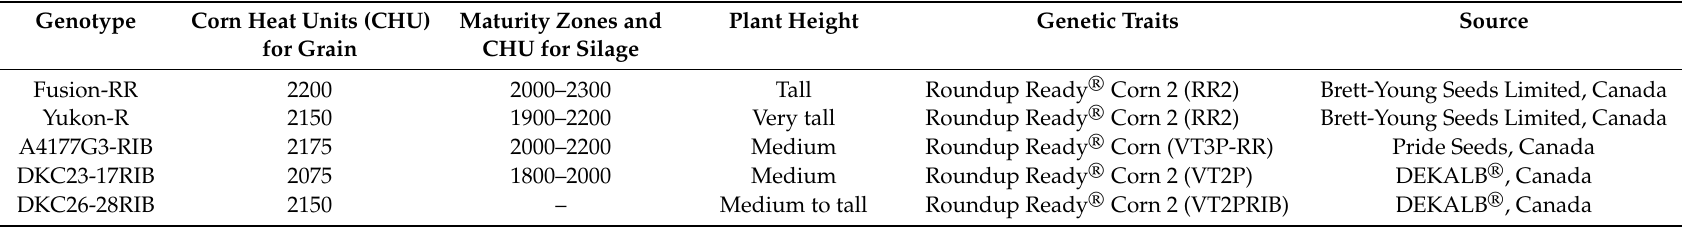
Table 3. Genotypic traits of the five silage-corn varieties cultivated under field conditions in a cool climate production system.